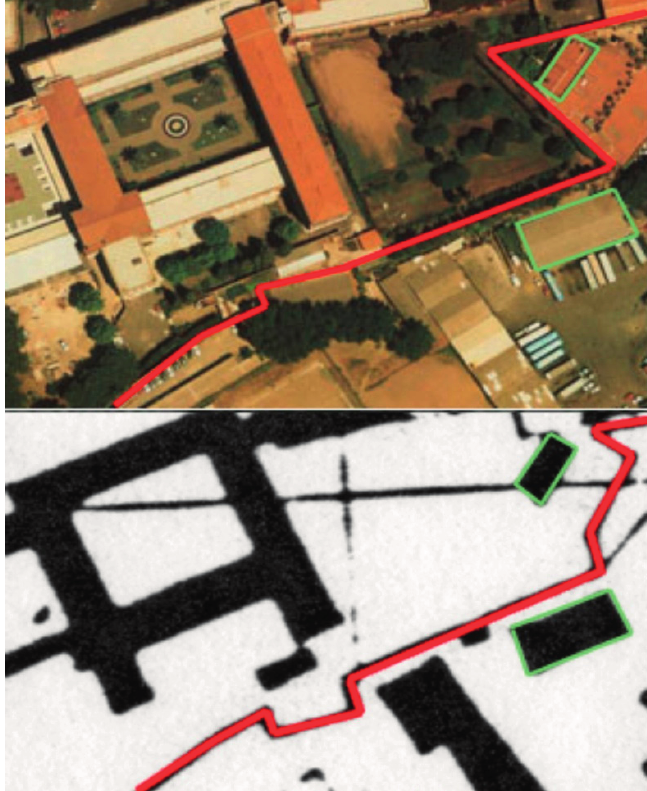
Figure 4. Contemporary cartographic error. Aurelian walls (San Giovanni). Aerial Map of Lazio, showing a wrong trace ( bottom